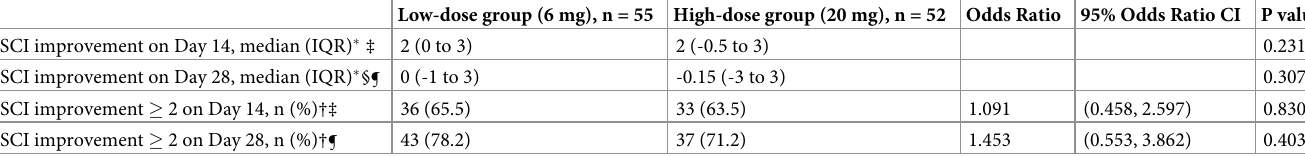
Table 2. Clinical improvement using the WHO-Ordinal scale for clinical improvement (WHO-OSCI).